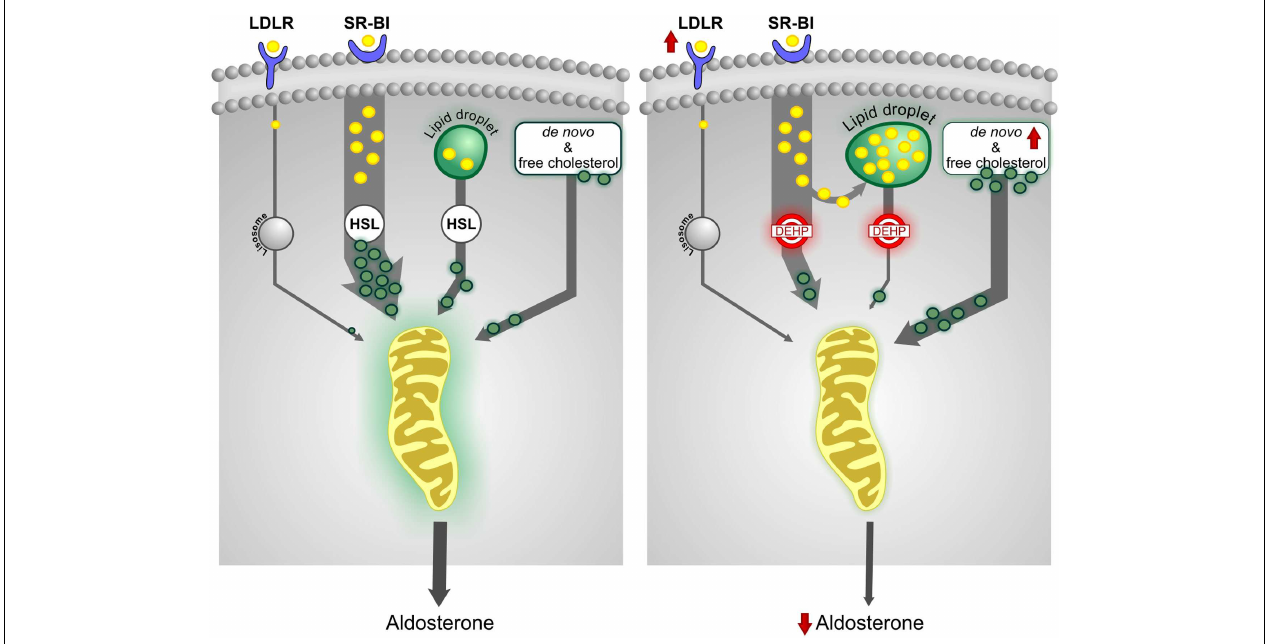
low-density lipoprotein receptor (LDLR) and de novo cholesterol synthesis pathway but decreases HSL expression. HSL function appears to be insufficient to release free cholesterol, thus decreasing the pool of free cholesterol. Some of the esterified cholesterol is shunted to lipid droplets, increasing their size.The data suggest that increased de novo cholesterol synthesis is critical to maintain